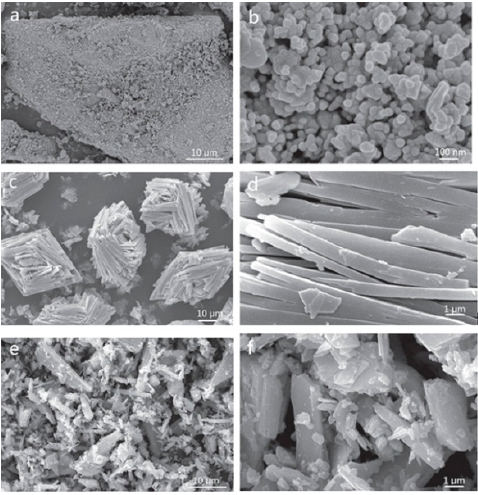
Figure 1. SEM images of ( a ), ( b ) sample 1; ( c ), ( d ) sample 2; and ( e ), ( f ) sample 3 [31].